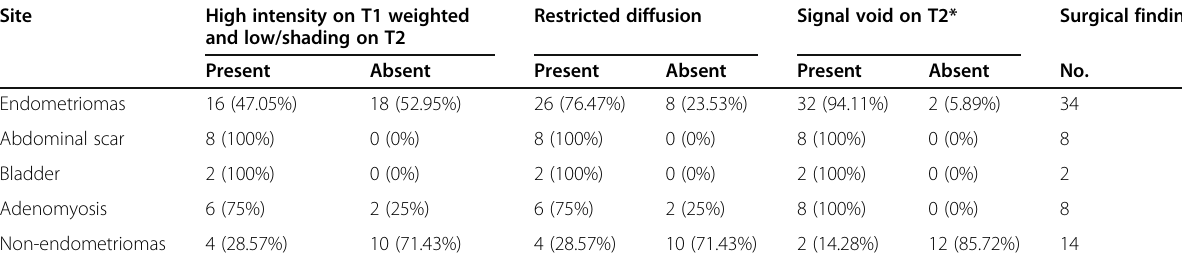
Table 2 MRI findings of surgically proven cases Site High intensity on T1 weighted Restricted diffusion Signal void on T2* Surgical and low/shading on T2